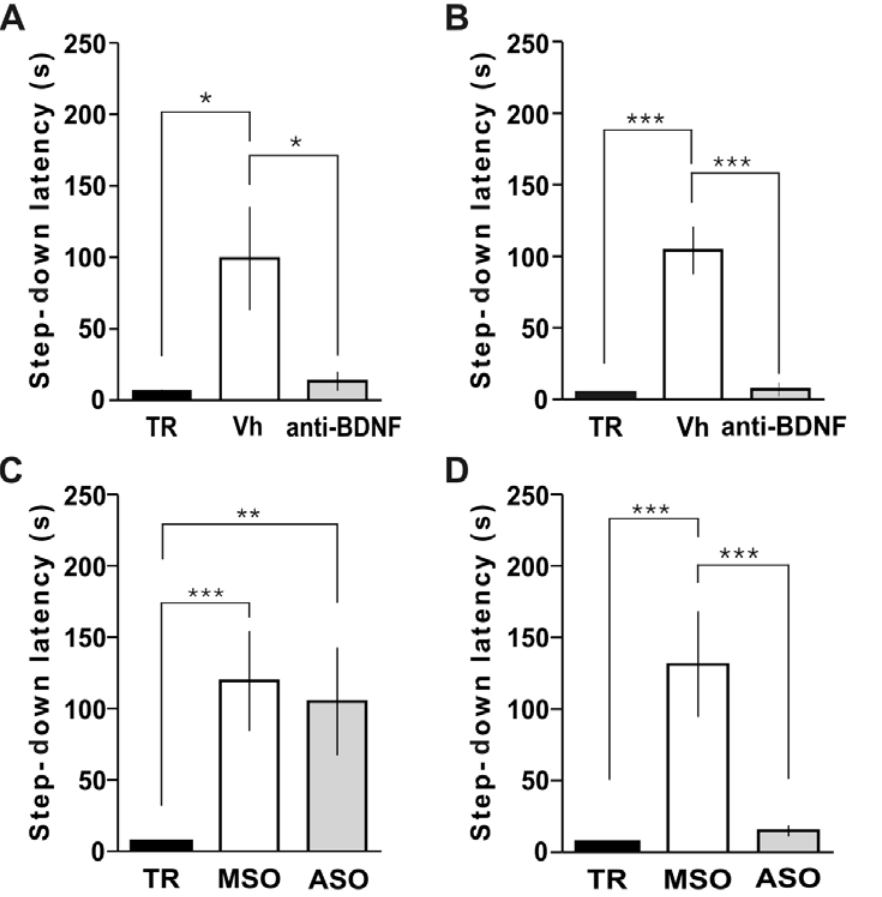
Figure 4. Different Requirement of BDNF Activity and Synthesis During the Two Time Windows of Memory Consolidation. Data are expressed as mean ( 6 SEM) of training (TR, black bars) or test session step-down latency at 24 h after IA training. Animals were infused intra-CA1 of the dorsal hippocampus with vehicle (Vh, white bars) or function-blocking anti-BDNF antibodies (1 m g/ m l, grey bars) 15 min before (A) or 3 h (B) after training. Animals were infused intra-CA1 of the dorsal hippocampus with BDNF MSO (white bar) or BDNF ASO (2 nmol/ m l, 1 m g/side, grey bar), 2 h before (C) or 1 h (D) after IA training. *p , 0.05, **p , 0.01, ***p , 0.001 vs Vh (A, B) or MSO (C, D), n=10 per group for each experiment. (Figure 6F) infused 2:45 after training abolished the increase in GluR1 expression occurring 3 h after training. These experiments indicate that the BDNF/mTOR signaling pathway controls the learning-induced increase in GluR1 15 min or 3 h after training.